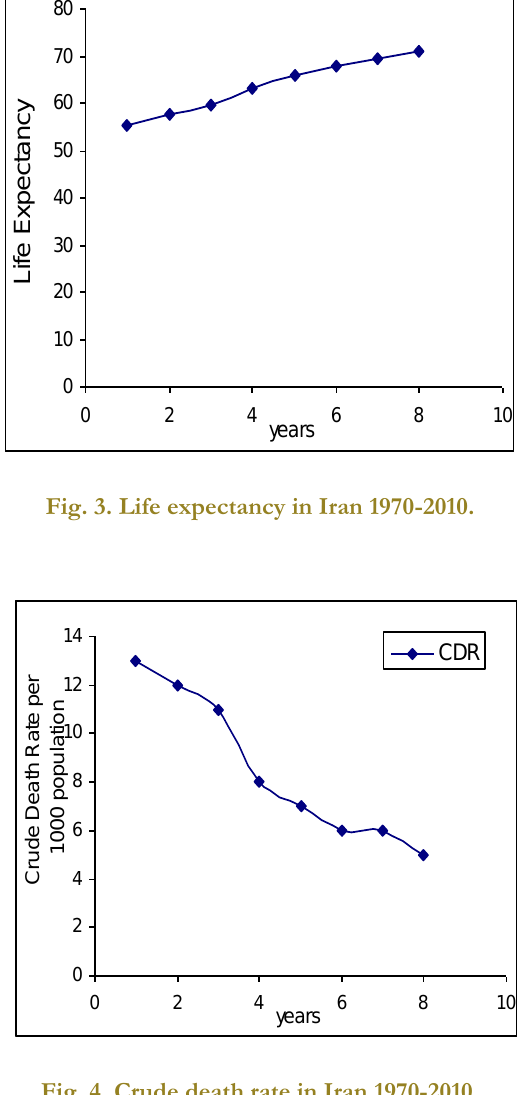
Fig. 4. Crude death rate in Iran